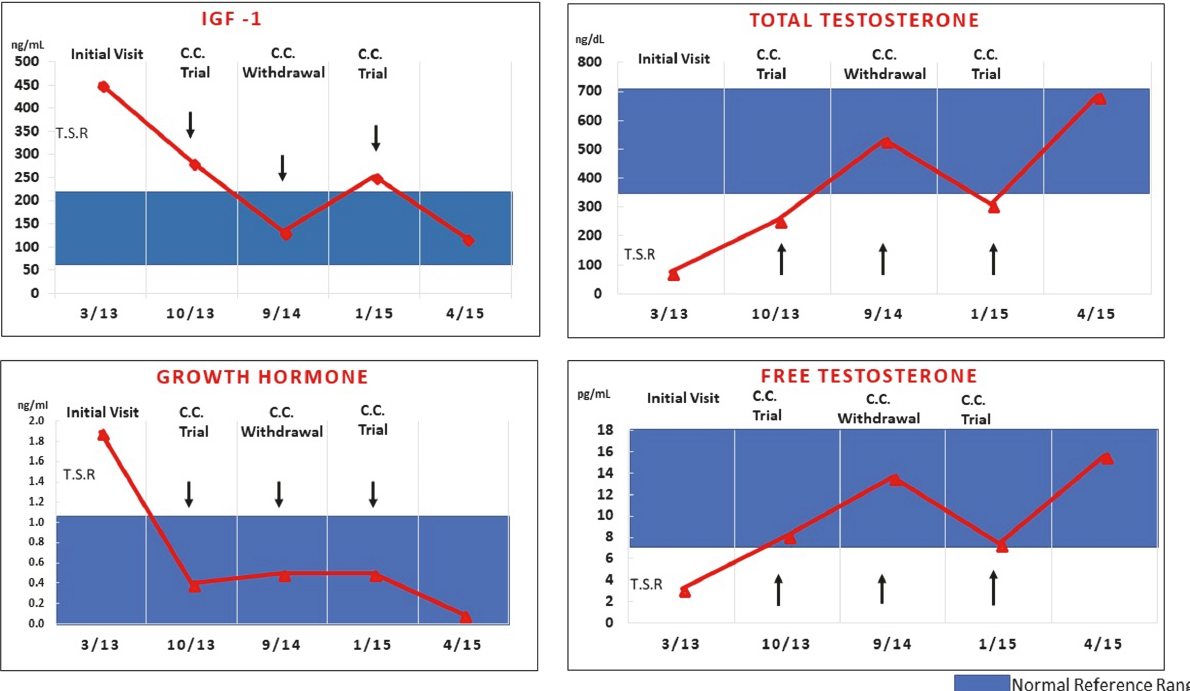
Figure 1: Timeline of treatment effects on serum IGF-I, growth hormone (GH), testosterone, and free testosterone levels. TSR: transsphenoidal resection. CC: clomiphene